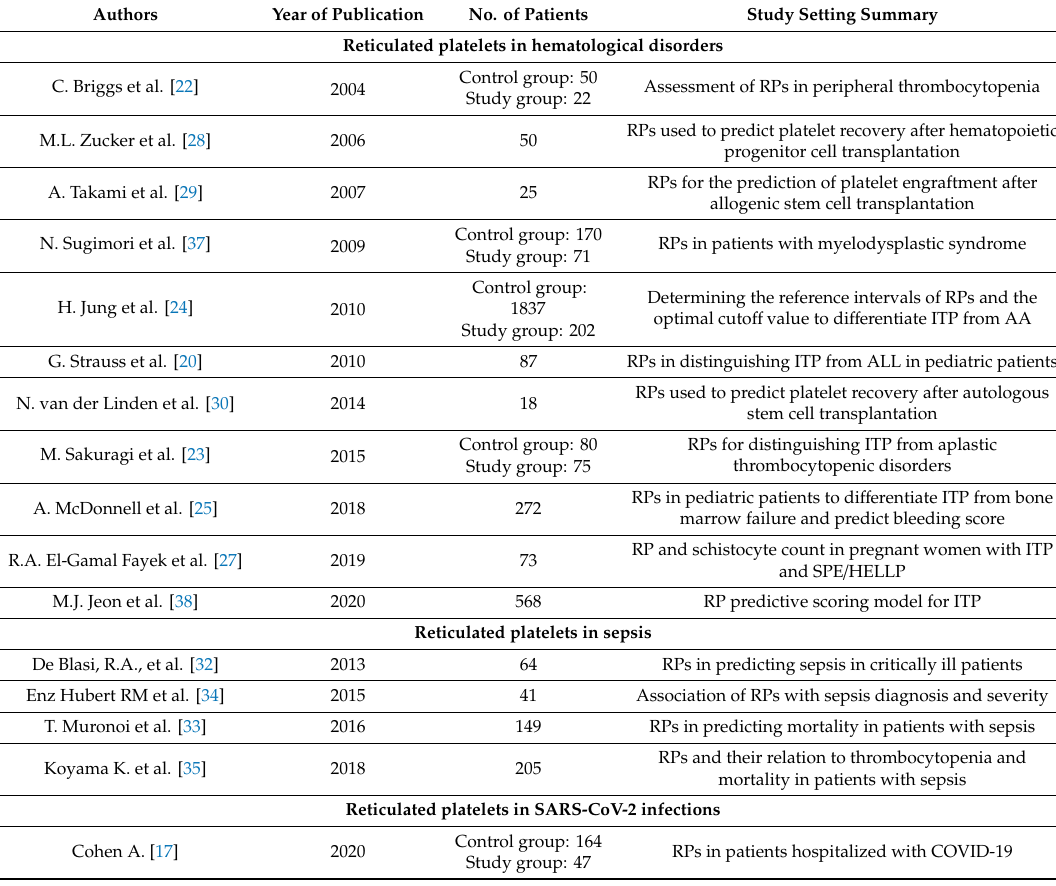
Table 1. Overview of the di ff erent studies of importance outside the cardiovascular